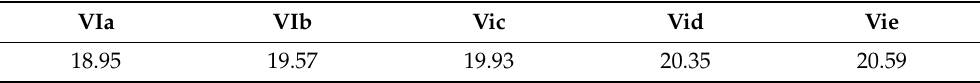
Table 5. Computed CCSD(T)/def2-TZVPP(ecp)//PBEh-3c RSEs (in kcal mol − 1 ) for model compounds VIa-e .